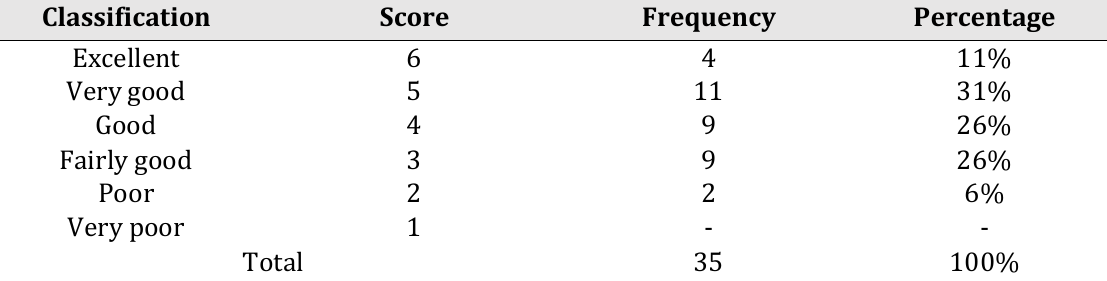
Table 15. the rate percentage score of students’ fluency